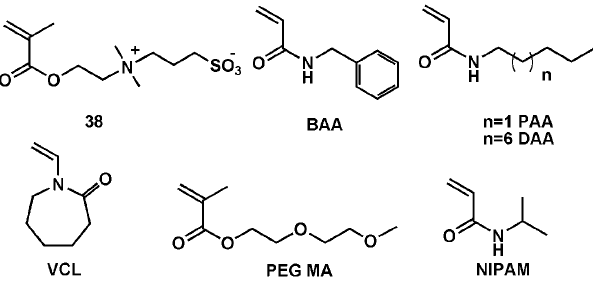
Figure 6. Structures of monomer (38) and monomers used in copolymers to vary UCST.